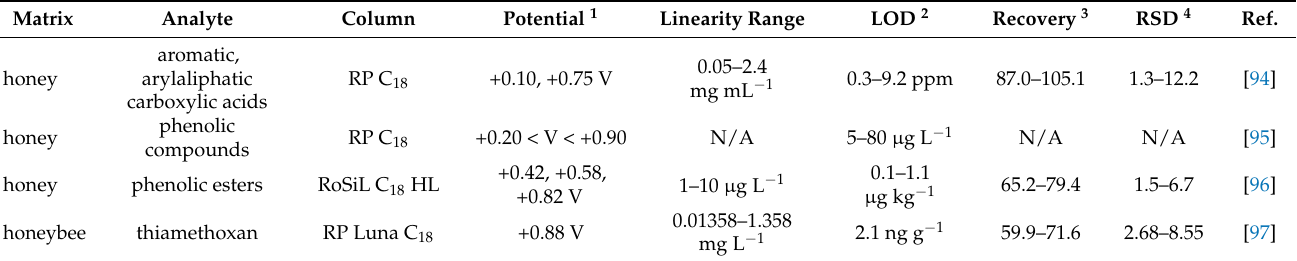
Table 6. HPLC-ED analysis performance in the analysis of different compounds in honey matrix. The term “N/A” means the information is absent in the